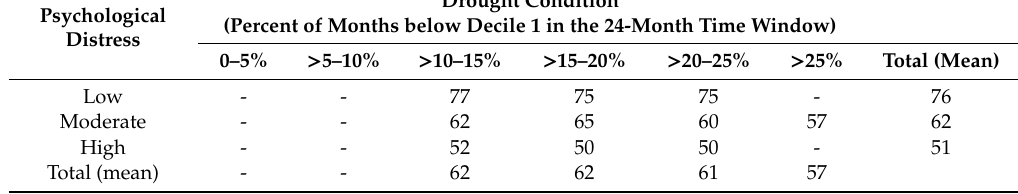
Table 8. Average SOC according to drought condition and level of psychological distress (K10) (note: weak SOC = 13–63; strong SOC =